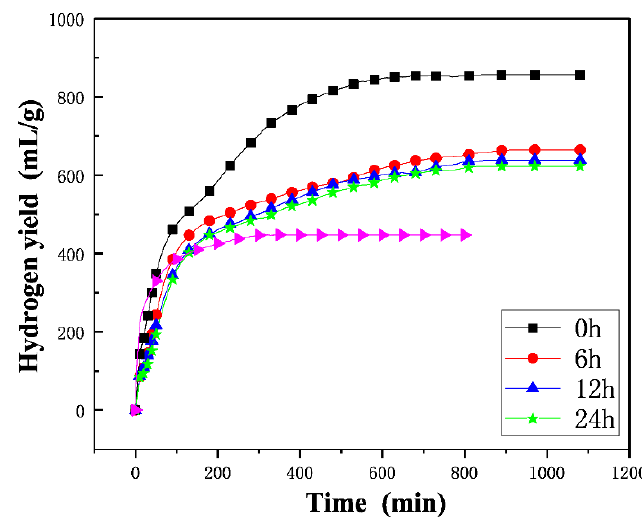
Figure 9. Hydrogen yields of the Al–10Bi–7Sn–3Cu composite powder reacting with 50 °C distilled water after being stored (25 °C and 60 RH%) for different times.